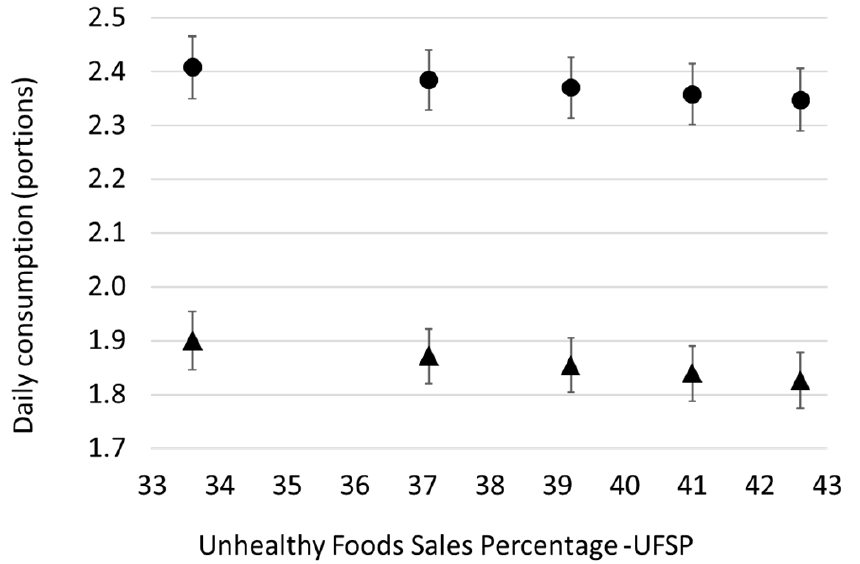
Figure 2. Association between unhealthy food sales percentage and BMI. Figure shows predicted BMI at Q midpoints (10th, 30th, 50th, 70th, and 90th centiles) based on a linear regression model. Model adjusted for sex, age group, and individual-level physical activity, as well as local-authority-level deprivation and ethnic mix.